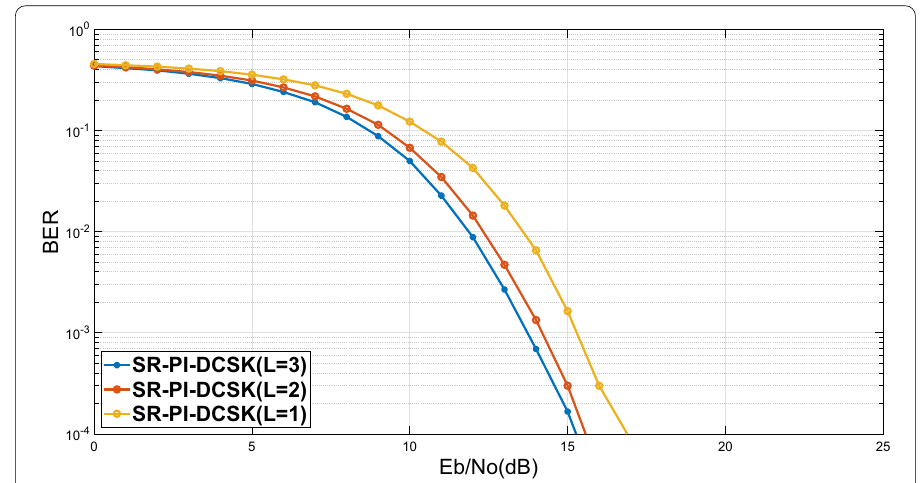
Fig. 8 The bit error rate performance at different frame lengths ( L = 1 , L = 2 and L = 3 ) for SR‑PI‑DCSK for β = 50